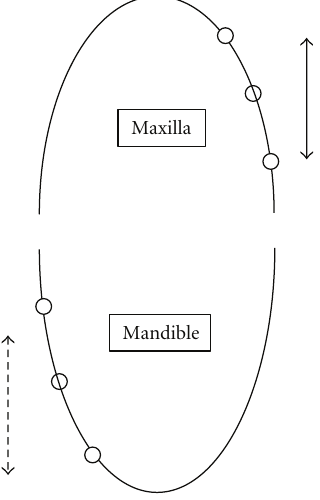
Figure 1: Schematic scheme of miniscrew sites. The distance between adjacent miniscrews is 20 mm. White circles stand for screws undergoing orthodontic force. Black circles stand for control screws. 300 cN was applied in maxilla (arrow A). 600 cN force was applied in mandible (arrow